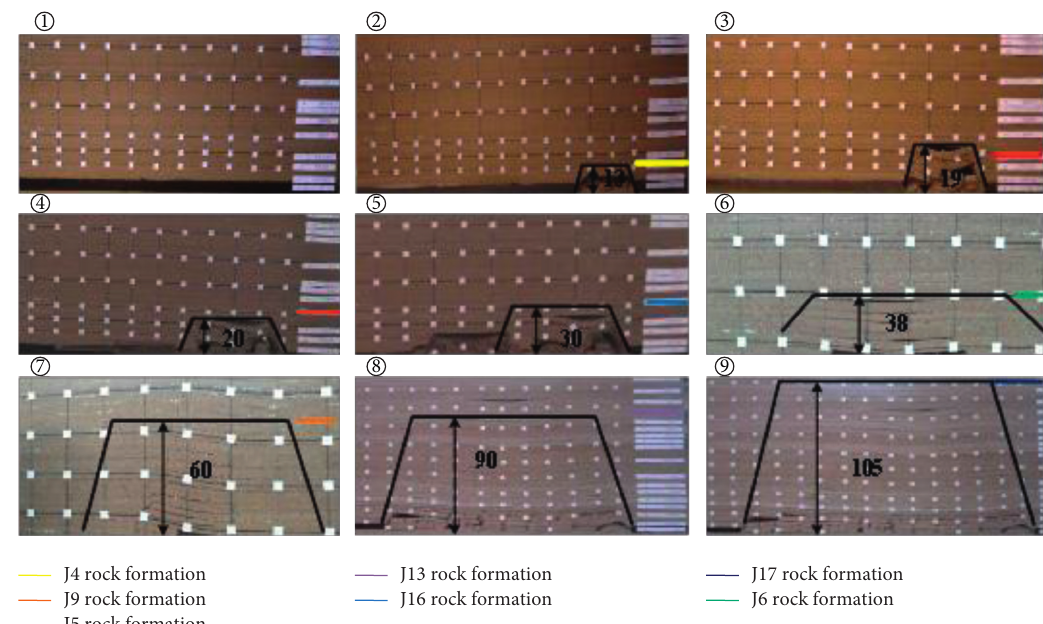
Figure 13: Development height of water-conducting fracture zone of scheme 3.